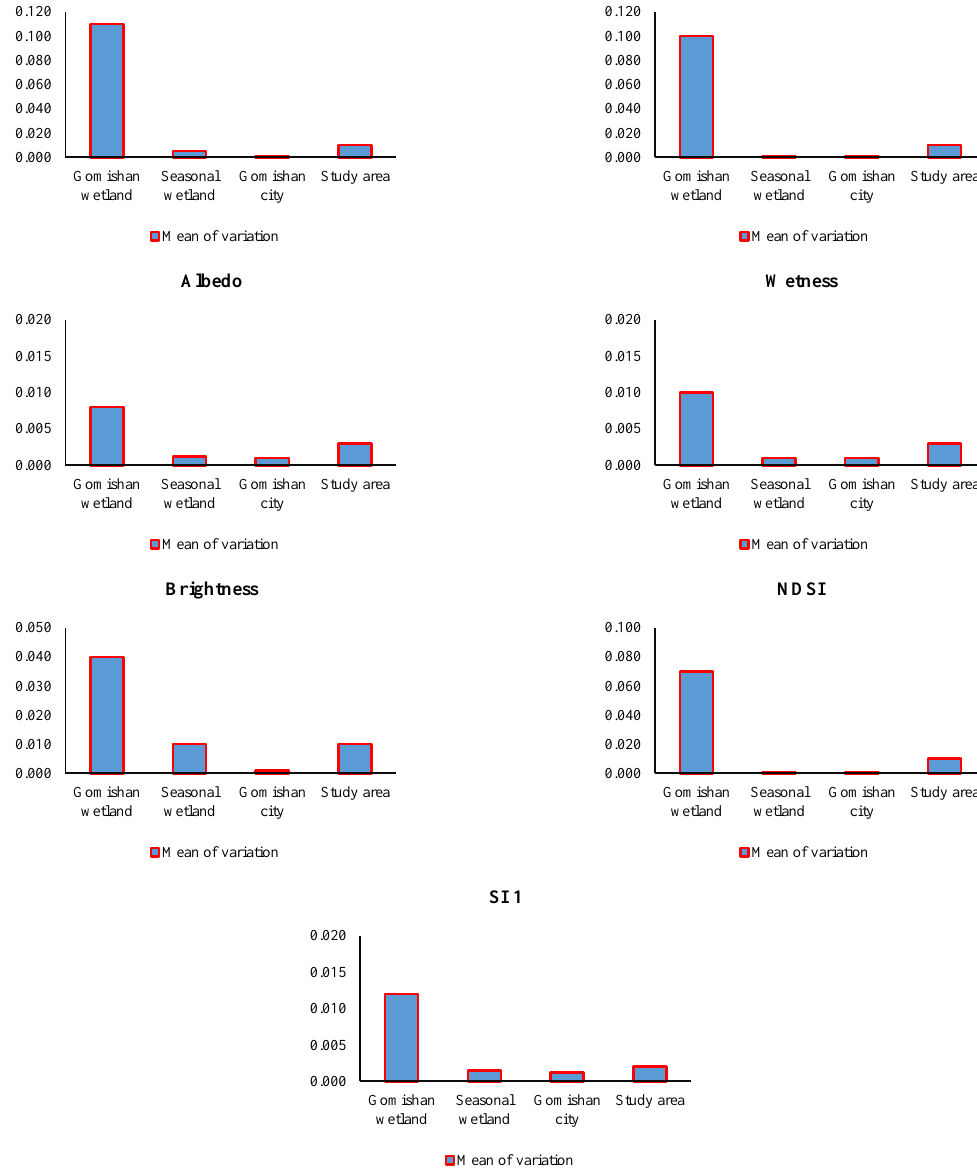
Figure 4. The mean of variation of the surface biophysical characteristics of the Gomishan city and wetland, seasonal wetland, and study area from